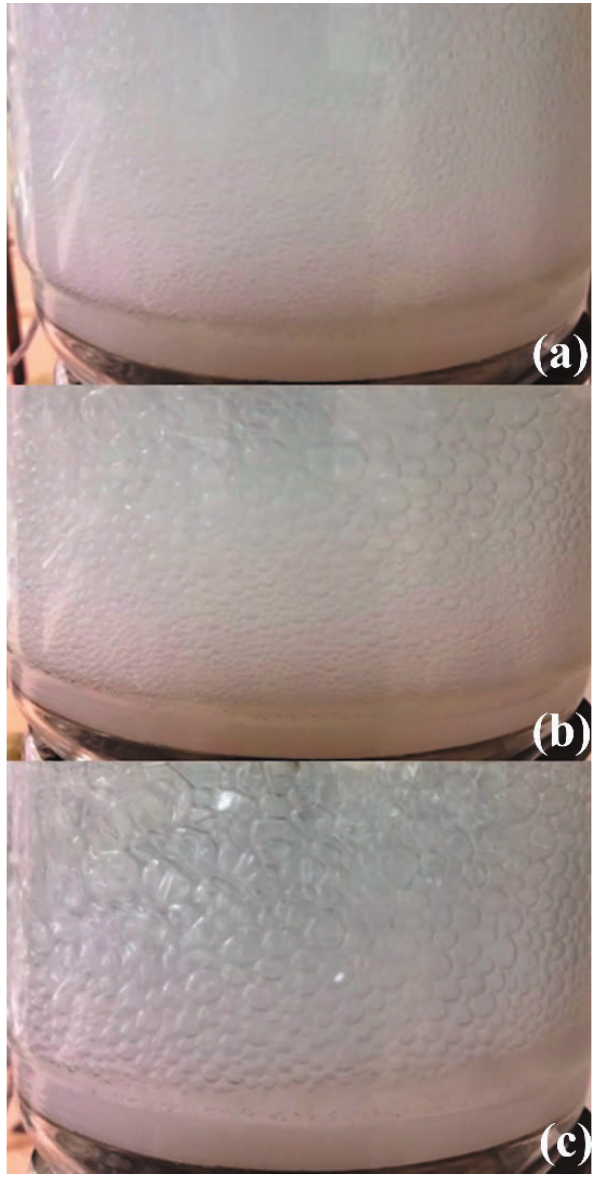
Figure 4. Photographs of the bubble sizes in NH 4 HCO 3 solutions in a BCE with an inlet of (dry) air at 275 °C, at experimental times: (a) 0 min ( b ) 10 min; and (c) 20